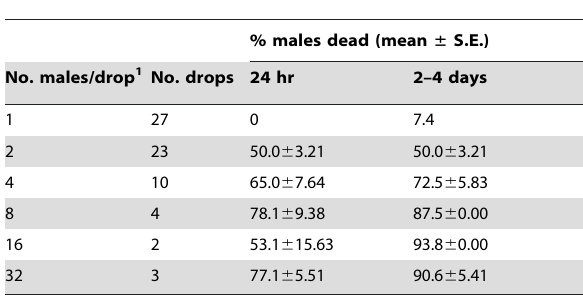
Table 1. Mortality (mean 6 S.E.) of male S. longicaudum 24 h and 2–4 days after being placed in groups of